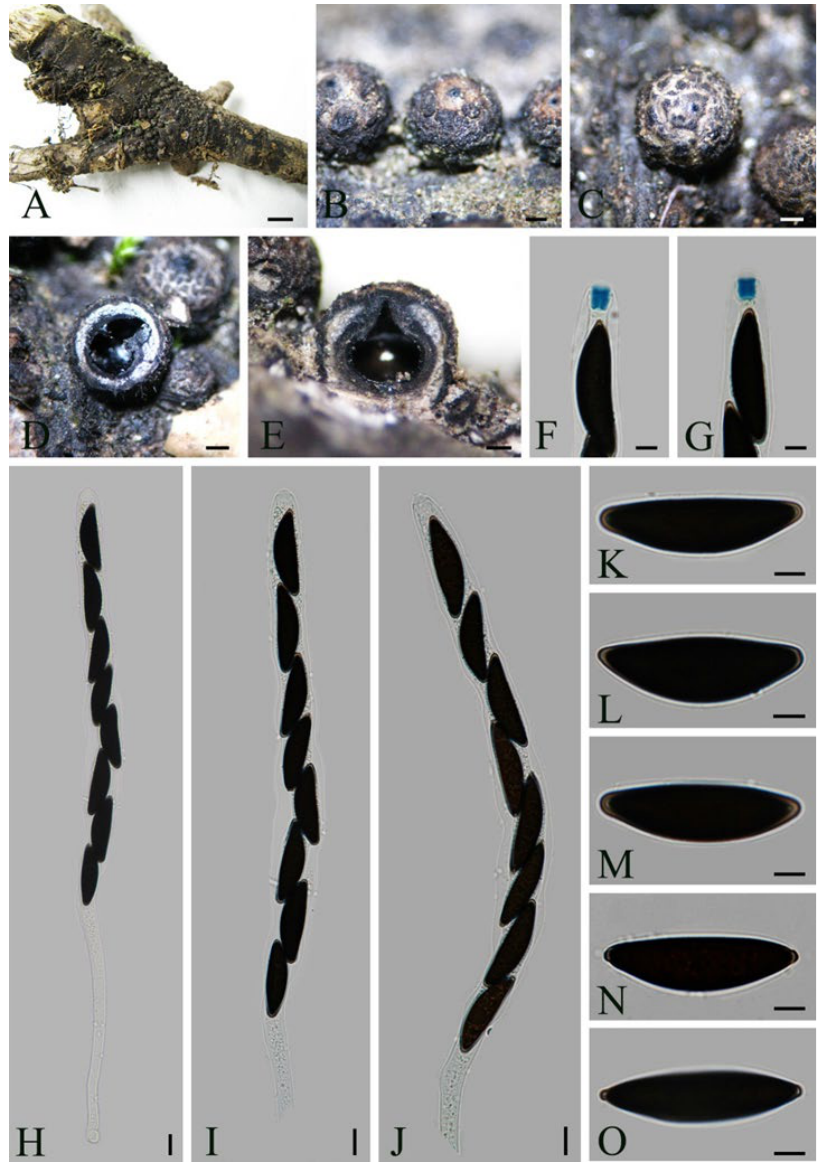
Figure 2. Rhizomaticola guizhouensis (GZUH0101,holotype) ( A ) Material; ( B , C ) Stromata on the surface of host; ( D , E ) Sections of stromata; ( F , G ) Ascus apex with a J+, apical ring (stained